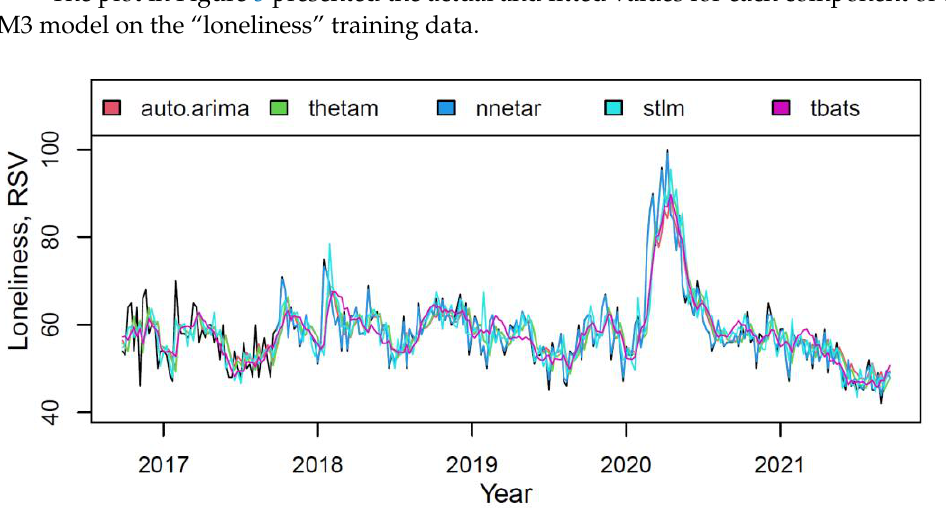
Table 6. The M3 model’s component weights for loneliness score forecasting.